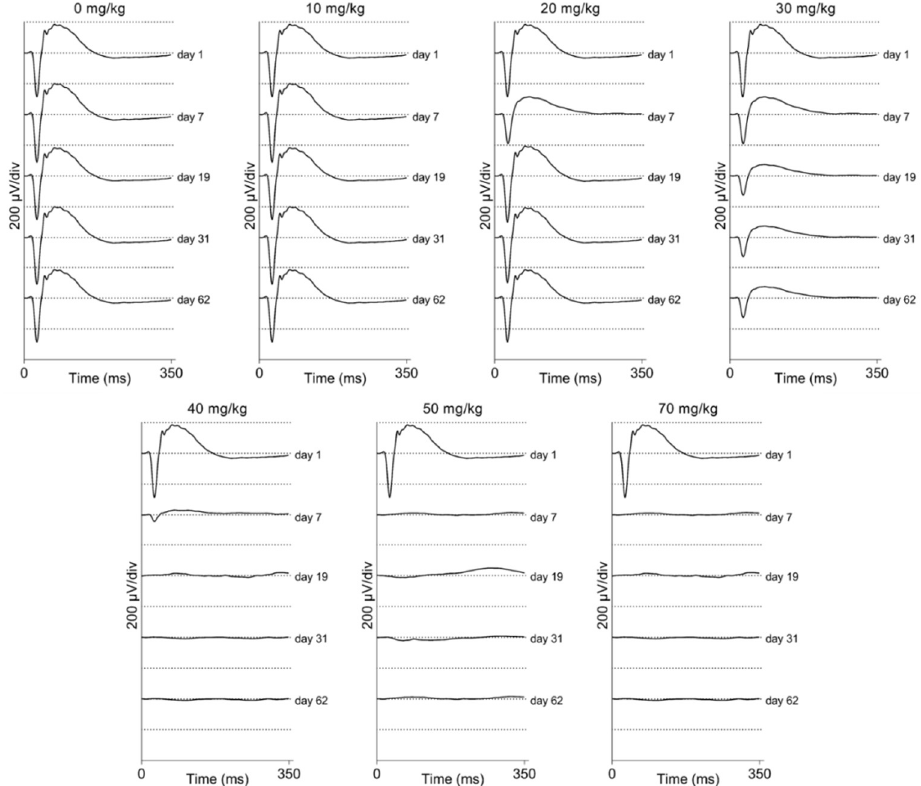
Figure 4. Averaged scotopic electroretinograms are shown for C57BL/6J mice ( n = 4 per group). The averaged traces per treatment group and per day of follow-up are plotted. No difference can be observed between the 10 mg/kg group and the control group by eye. A temporary effect was seen for the 20 mg/kg group: a slightly decreased response was seen a week post-injection. A moderate effect was seen for the 30 mg/kg group: decreased responses were observed from seven-days post-injection onwards. This effect is larger later in time but seems stable after one-month post-injection. Direct and drastic effects were observed for higher treatment groups (40, 50, and 70 mg/kg). ERG responses were (almost) completely not recordable from one-week post-injection onwards. Similar effects were observed in ERG recordings from Brown Norway rats (Figure 5).